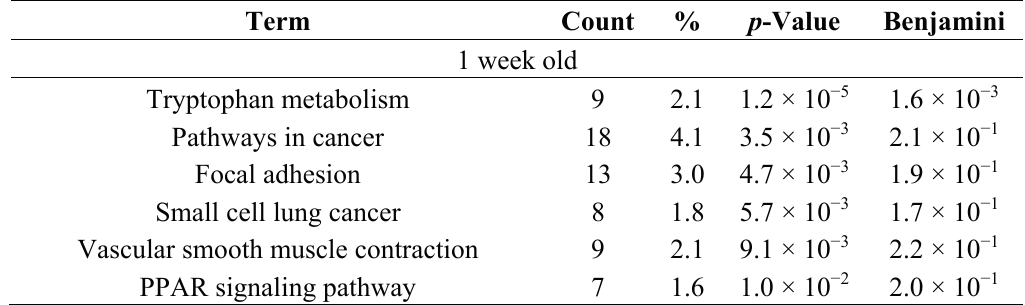
Table 1. Significantly regulated Kyoto Encyclopedia of Genes and Genomes (KEGG) pathways in the kidney of maternal melatonin-treated offspring vs. control at different